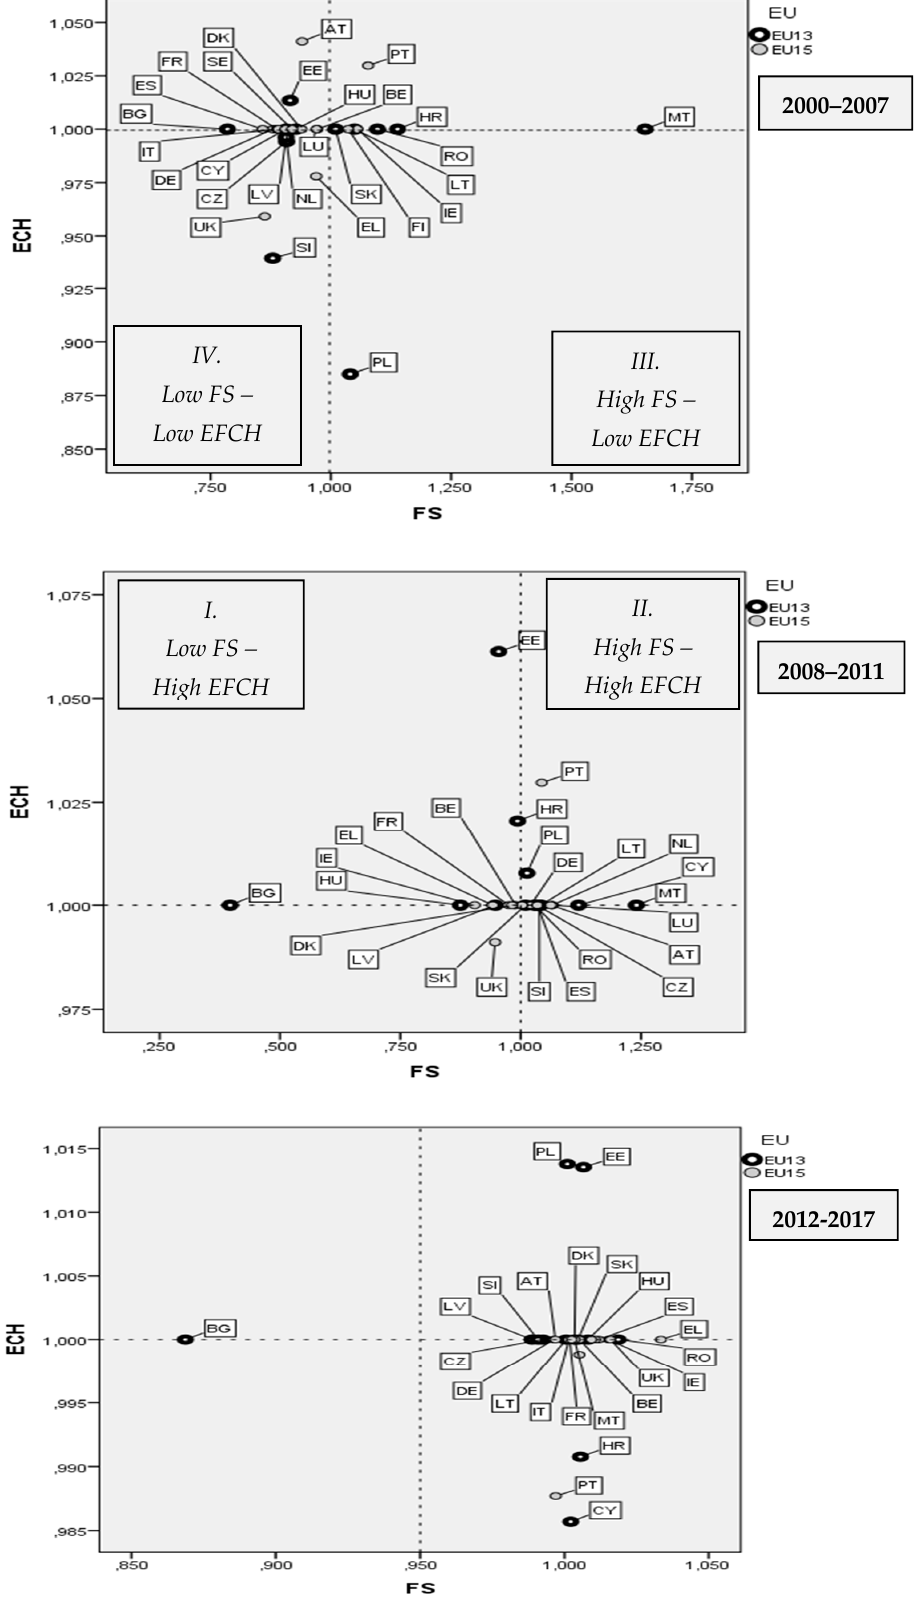
Figure 3. Comparison of EU15 and EU13 distances in ECH and FCH (source: own calculation and elaboration).